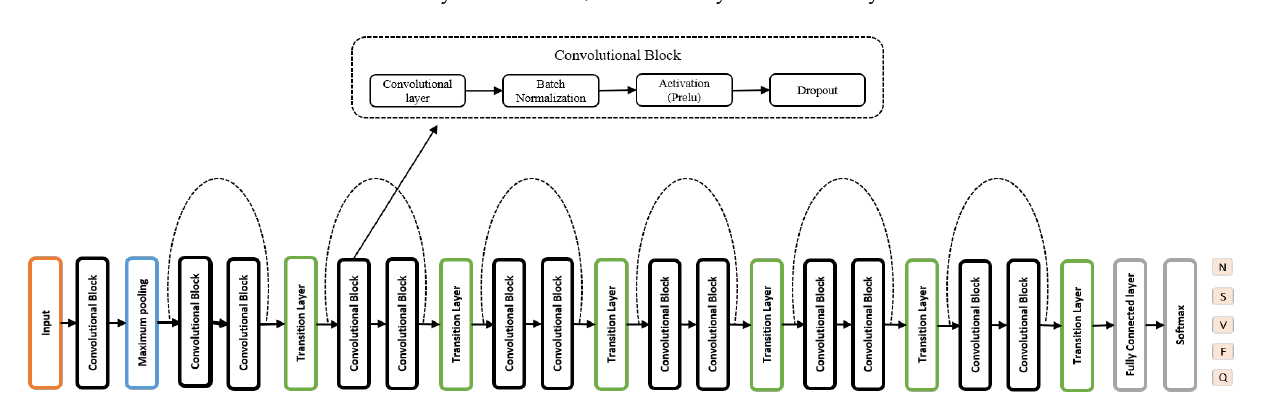
Figure 3. Architecture of the proposed deep learning model.